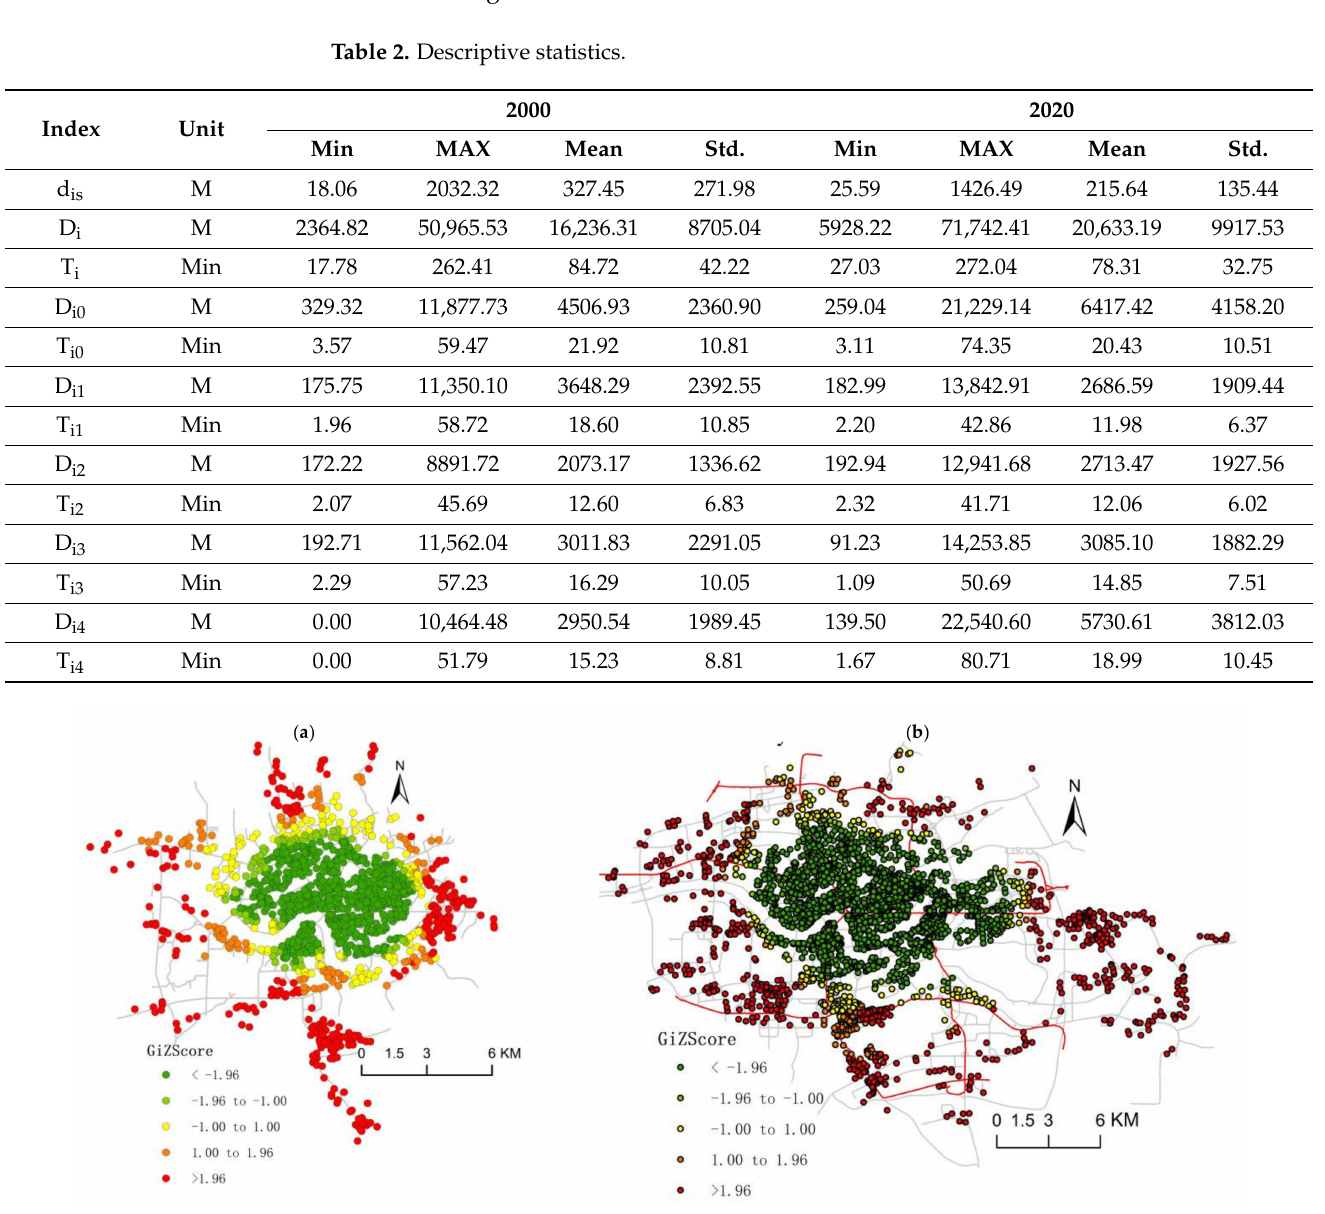
Figure 4. Hotspot distribution of RCs according to total travel time to five types of destinations in Nanning city 2000 and 2020. Overall Accessibility of RCs Cluster in 2000 ( a ); Overall Accessibility of RCs Cluster in 2020 ( b